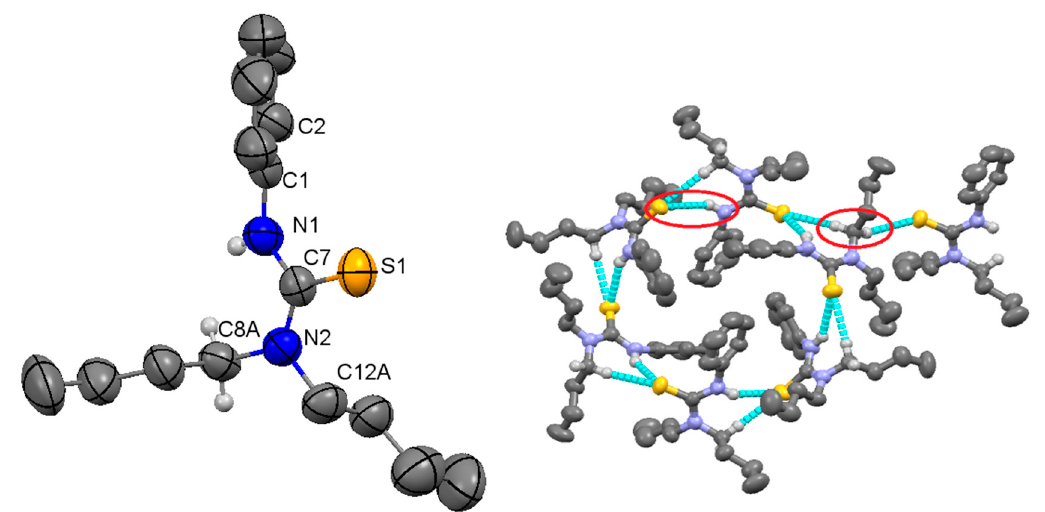
Figure 3. Single crystal structure ( left hand) of compound 4 , ellipsoids are drawn at 50% probability level, H-atoms except NH and CH 2 are omitted and selected atoms have been numbered. A cyclic hexamer ( right hand) is shown, molecules are linked with the help of S–H interactions making a macrocyclic ring containing six thiourea molecules (See Table 2 for selected structural parameters).